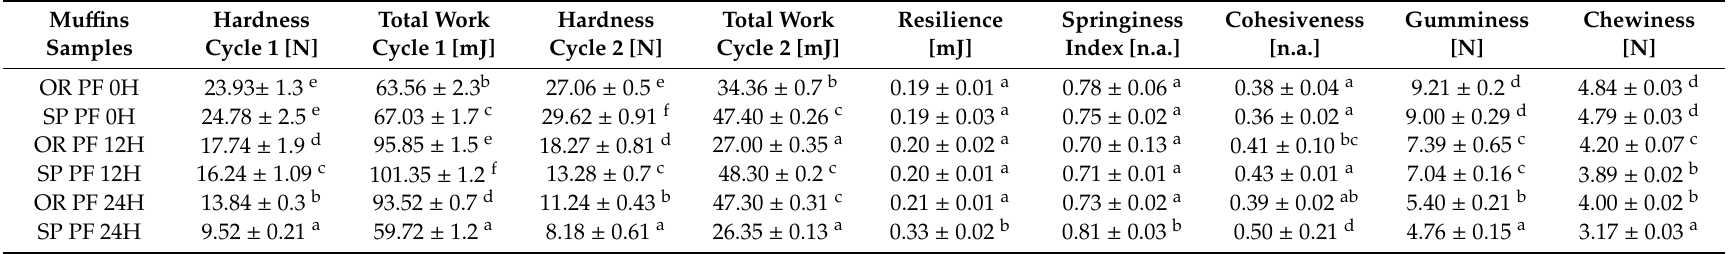
Table 5. Texture profile analysis of mu ffi ns sample